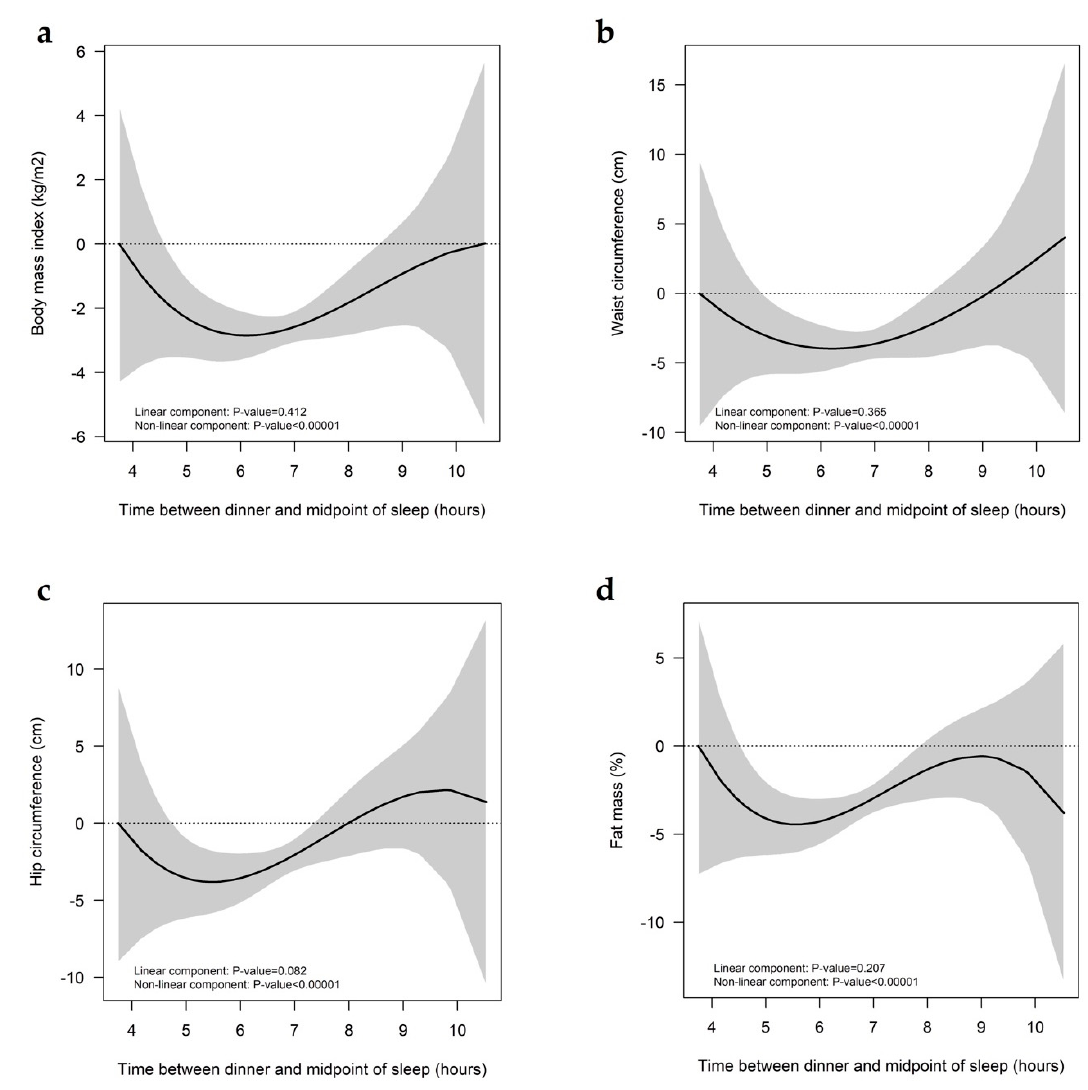
Figure 1. Restricted cubic splines representing the associations of the TDM with ( a ) body mass index, ( b ) waist circumference, ( c ) hip circumference, and ( d ) fat mass percentage. TDM, time elapsed between dinner and the midpoint of sleep. The models were adjusted for age, diet quality, total energy intake, and physical activity level. The gray band indicates the confidence levels for the regression line.